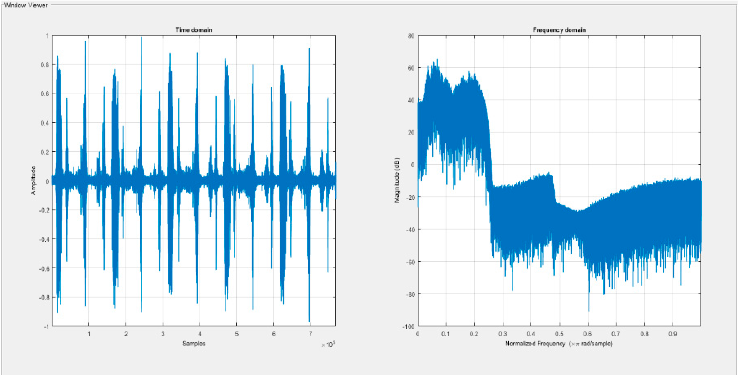
Figure 11. Changed signal generated by a valve head-seat unit failure. The comparison of the signal source of AE elastic waves from properly working valve unit of a mud pump ( up ) and early condition of the valve unit failure ( down ).